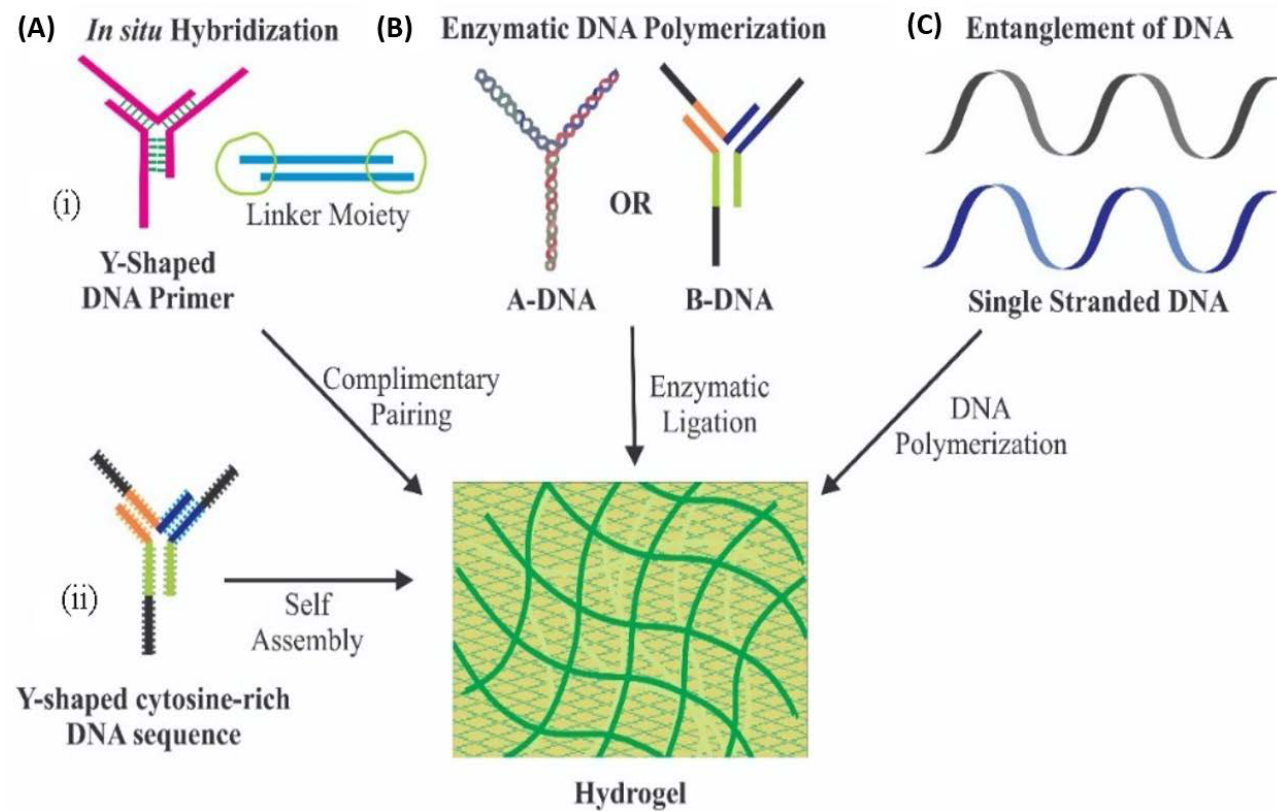
Figure 2. Schematic representation of the DNA hydrogels formation by various techniques. ( A ) Hybridization of DNA with its complementary strands using linker moieties ( i ) and i-motifs ( ii ); ( B ) enzymatic ligation and ( C ) entanglement of DNA.